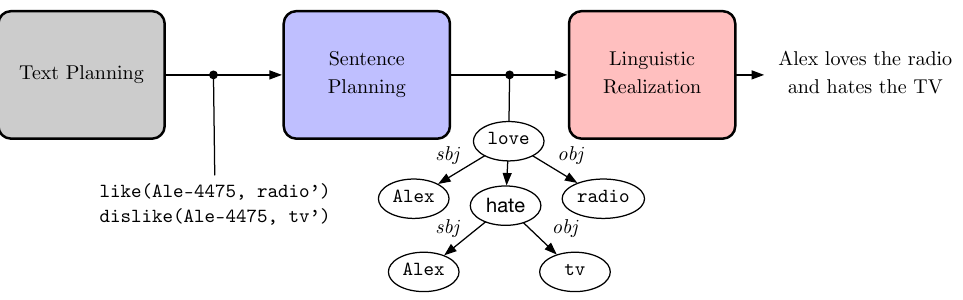
Figure 1. The standard NLG three macro-steps